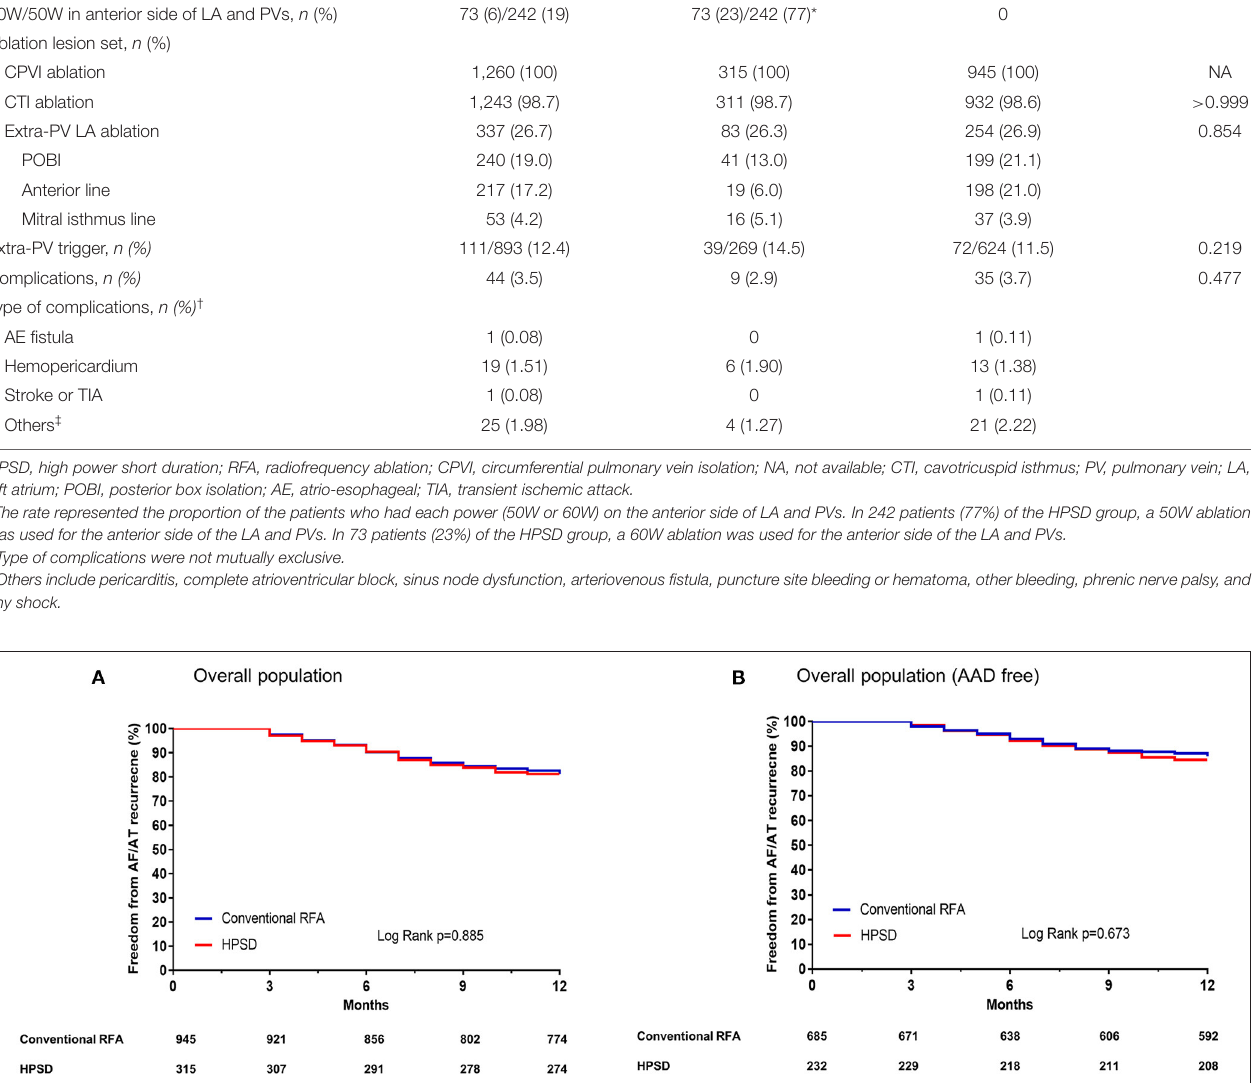
FIGURE 2 | Kaplan–Meier curves for the atrial fibrillation (AF) recurrence-free survival rates in the overall population (A) and in the population without antiarrhythmic drugs [AAD, (B) ]. HPSD, high-power short-duration radiofrequency ablation; RFA, radiofrequency